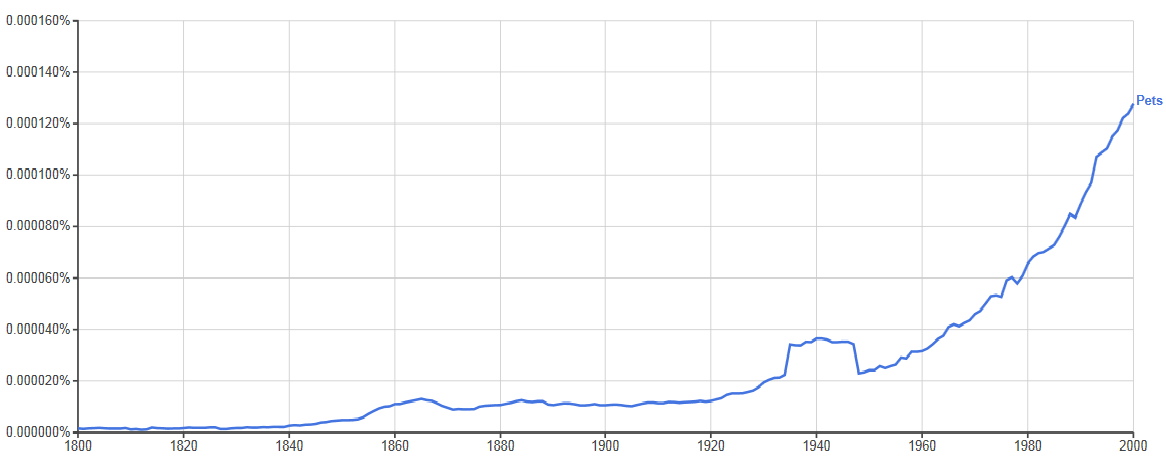
Figure 1 . Changes in the relative frequency of the word “pet” in books printed in the United States between 1800 and